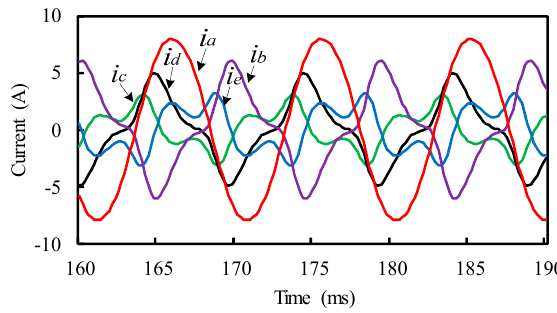
Figure 12. Currents under fault ‐ tolerant conditions. Energies 2016 , 9 , 860